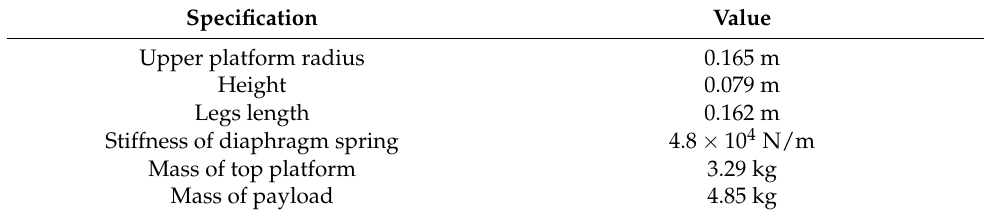
Table 1. Main specifications of the platform model.